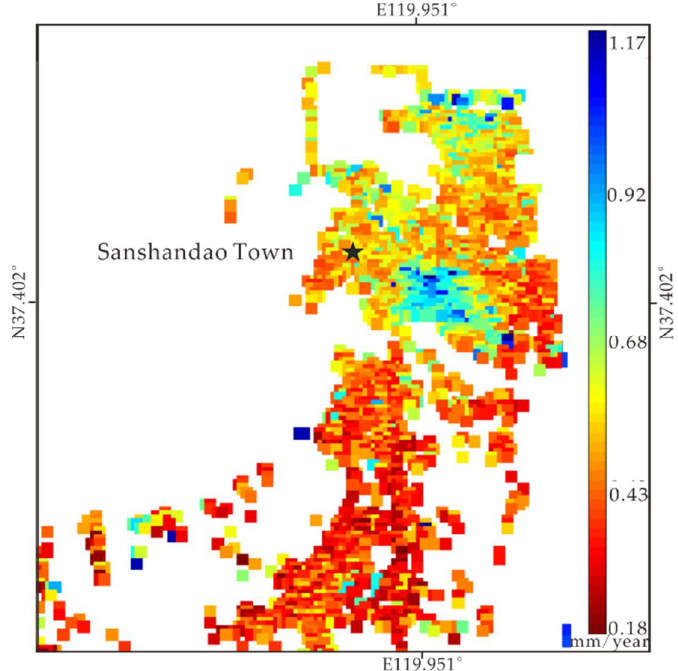
Figure 6 . The standard deviation of the mean LOS velocity estimation. Figure 6. The standard deviation of the mean LOS velocity